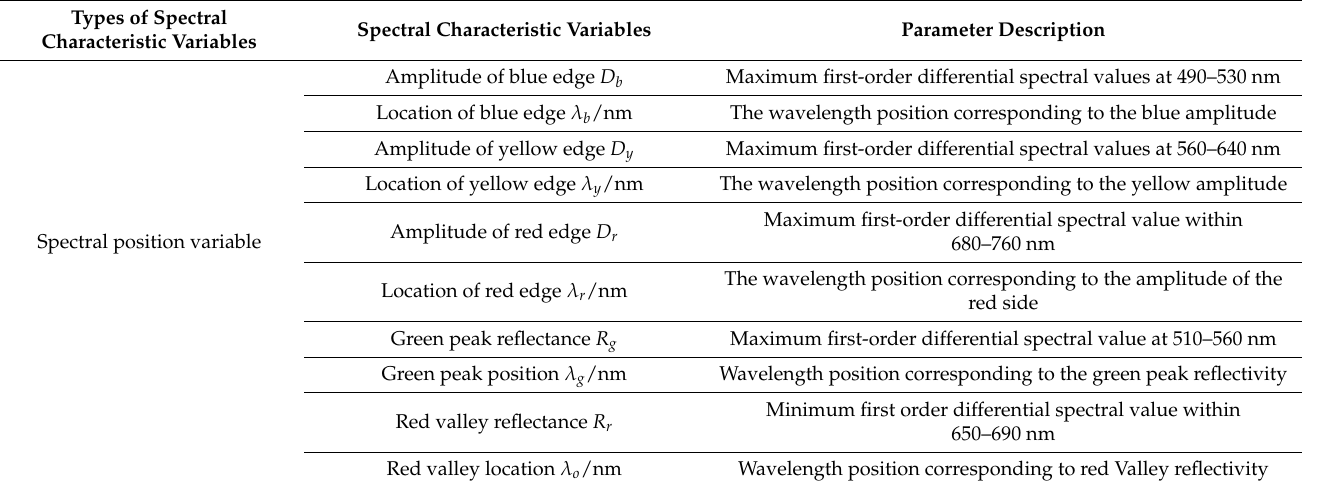
Table 1. Hyperspectral characteristic parameters and description.